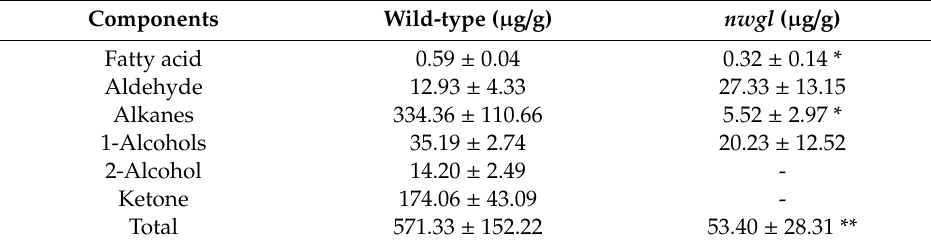
Table 1. Cuticular wax composition of leaf blades from wild-type and nwgl plants.